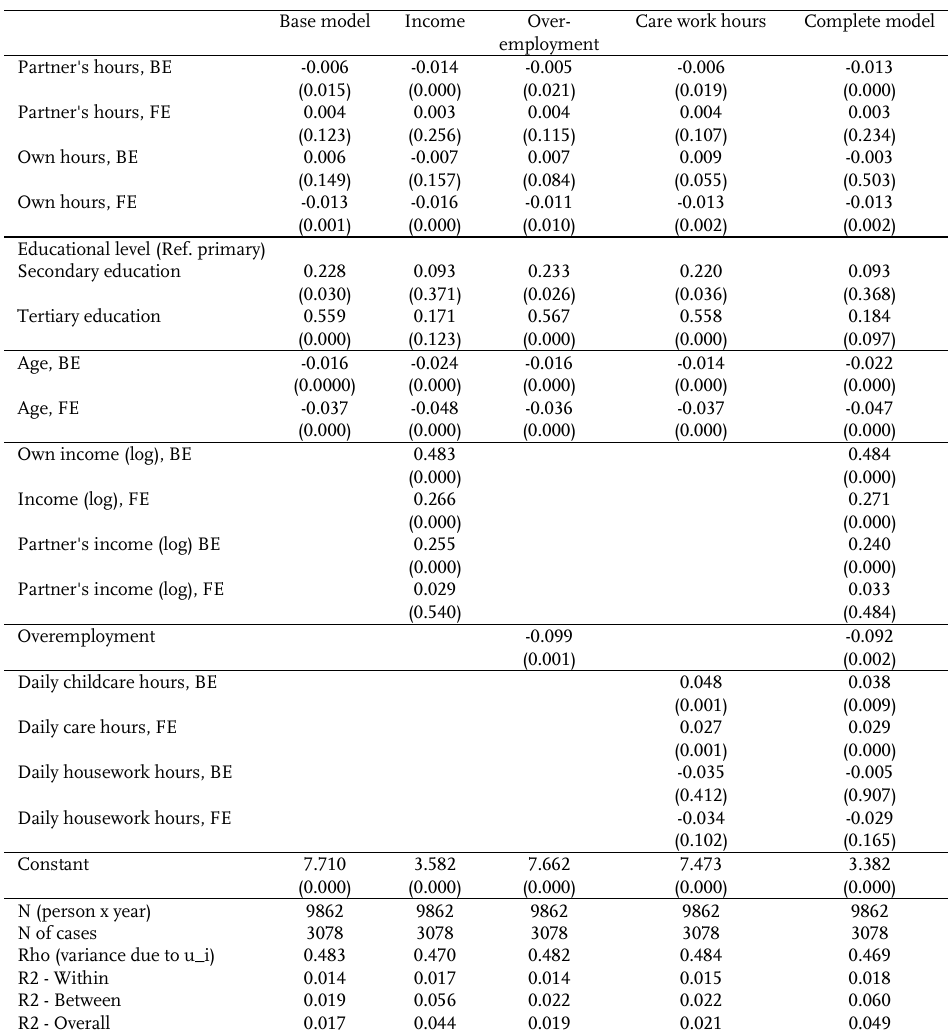
Table A.1 : Estimated coefficients of the hybrid model: Men with children < 14 in the household; p values in parentheses 1 Base model Income Over- Care work hours Complete model employment Partner's hours,